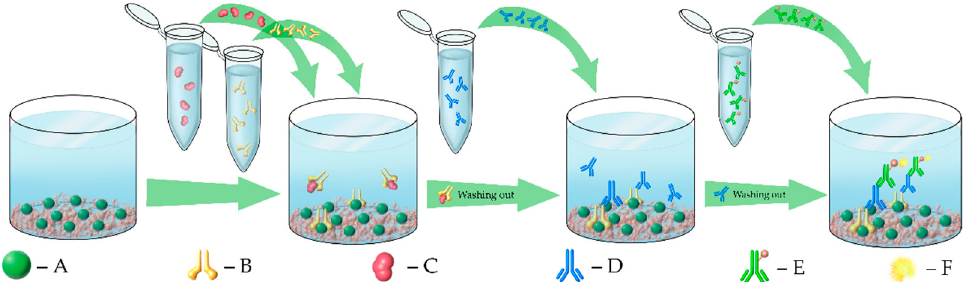
Figure 2. Schematic illustration of the enzyme-linked immunosorbent assay (ELISA). The wall of each well of a 96-well microplate was coated with a macromolecule showing high affinity to a given integrin (an RGD sequence-based synthetic polymer or ECM protein, e.g., vitronectin, fibrinogen or S-protein (the SARS-CoV-2 spike protein receptor binding domain)) and the remaining free surface was blocked with bovine serum albumin (BSA) ( A ). The corresponding integrin ( B ) was allowed to interact with the surface-immobilized macromolecules in the presence or absence of the ligands (glyphosate and its related compounds) at various concentrations ranging from 0 to 22 mM ( C ) that could modulate this binding process. The integrin molecules bound to the coating macromolecules were detected by an integrin-specific primary antibody ( D ), followed by an IgG-specific secondary antibody conjugated to a tracer enzyme (horseradish peroxidase, HRP) ( E ) and a colorimetric reaction of HRP using hydrogen peroxide as a substrate and 3,3 ′ ,5,5 ′ -tetramethlybenzidine (TMB) as a chromophore ( F ). If the ligand inhibited binding of the integrin molecules to the coating macromolecules, further steps of the ELISA process were blocked, leading to no color signal formation.